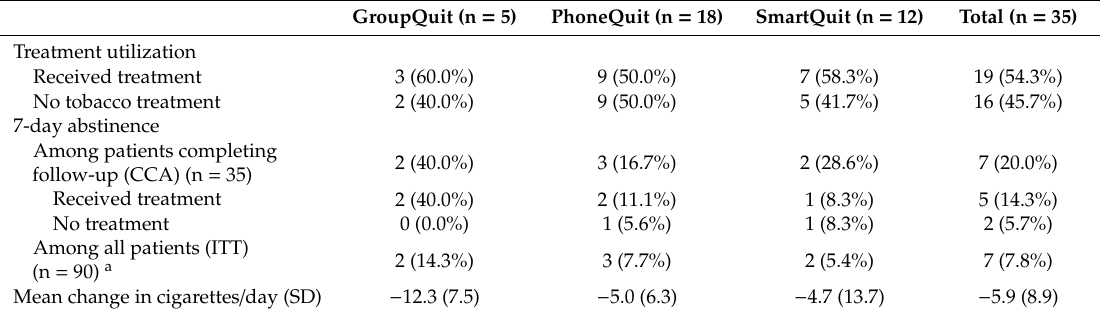
Table 4. Smoking outcomes at 12 weeks among follow-up completers (n = 35).